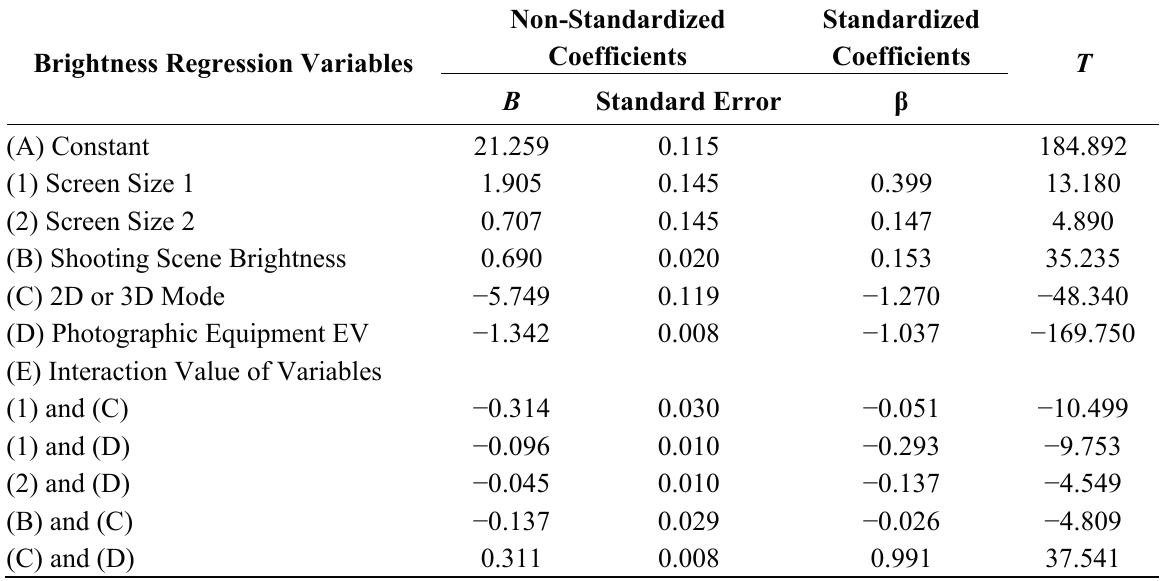
Table 6. Statistical coefficients of linear regression